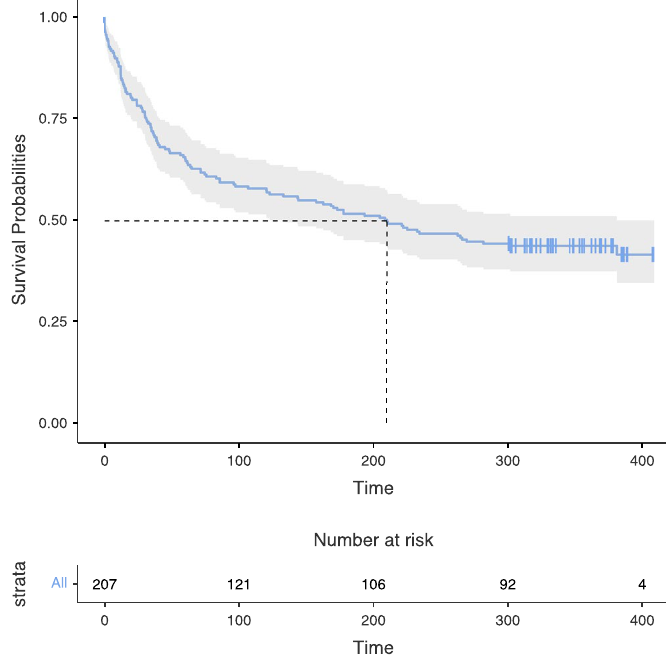
Figure 1. Overall survival among HIV population. This figure shows the overall survival of the cohort of People Living with HIV (PLWH) diagnosed between 1985–1994 in follow-up at the HIV outpatient clinic of the Unit of Infectious Diseases of the “Garibaldi” Hospital in Catania, Italy. At the end of the period of observation, 42.9% of the cohort was still alive. Table 2. Long-term survivors and causes of death.